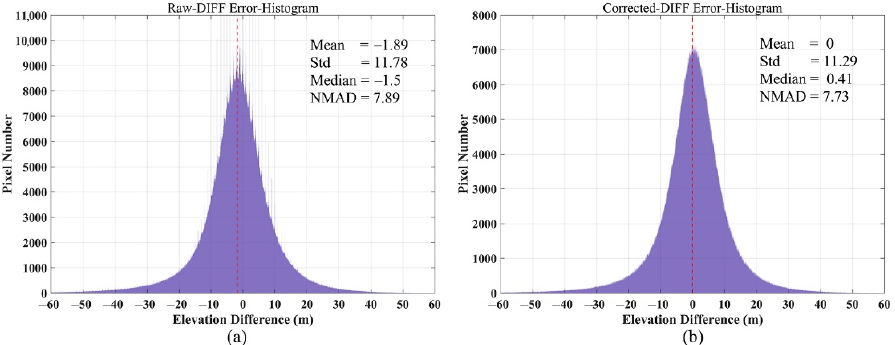
Figure 5. The elevation differences and the corresponding statistical histograms over stable regions